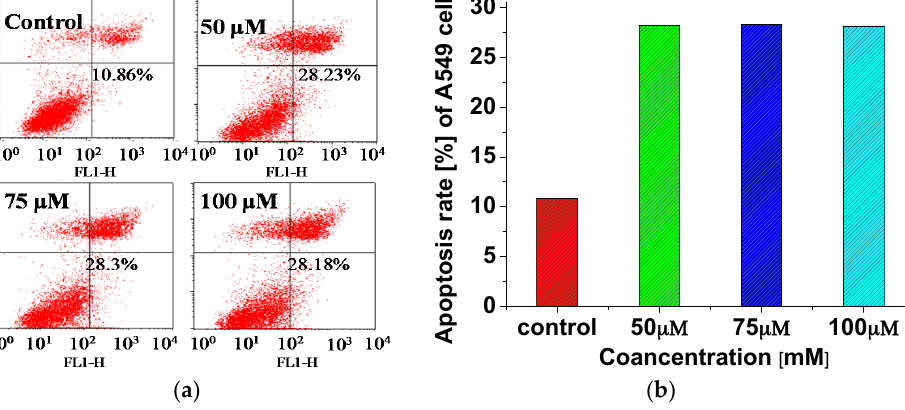
Figure 2. ( a ) Flow cytometric (FCM) analysis of the apoptosis of A549 cells treated with complex 1b after 24 h. The effect of 1b (50, 75, and 100 μ M) on A549 cell apoptosis was determined by flow cytometry. Untreated (control) cells or cells treated for 24 h were harvested, fixed, stained with Annexin V/PI, and assessed for cell apoptosis distribution by flow cytometric analysis; ( b ) Percentages of apoptotic cells were measured by the annexin V/PI flow cytometry analysis, as described in the Experimental section. The y-axis plots the sum of early and late apoptotic cells as the mean ± standard deviation of three independent experiments.